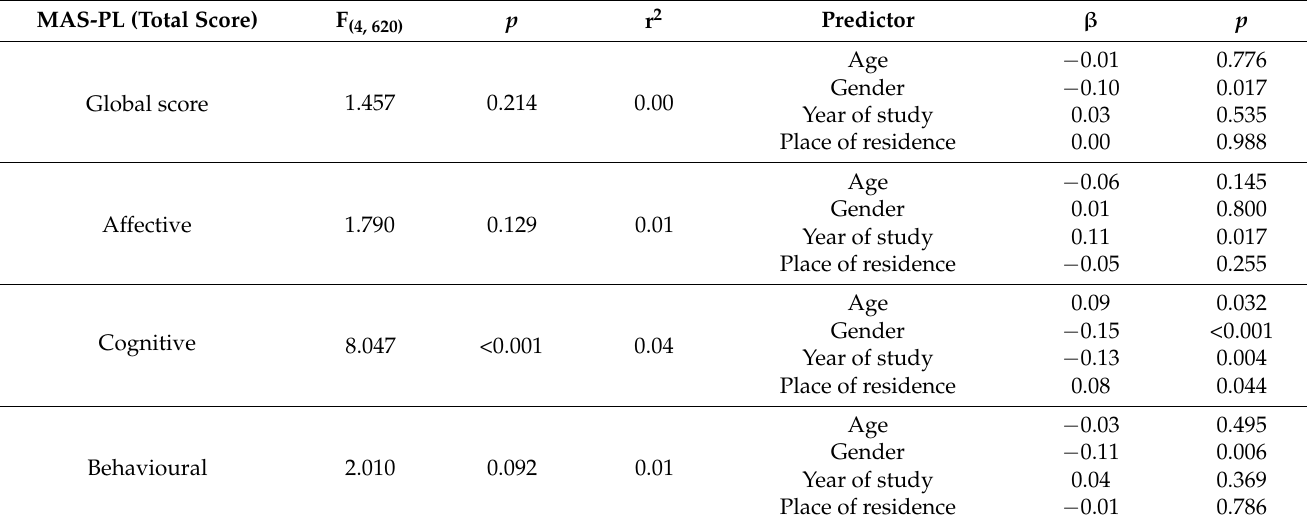
Table 8. Assumption of regression analysis of the results of MAS-PL scores (total score, affective, cognitive and behavioural subscales): Scheme